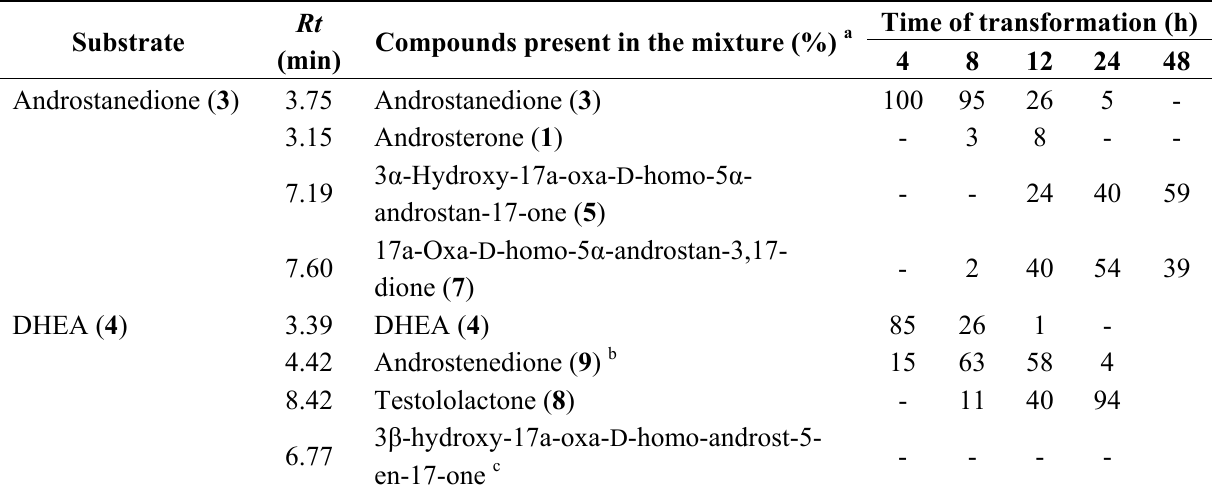
Table 2. Time course of the transformation of androstanedione ( 3 ) and DHEA ( 4 ).